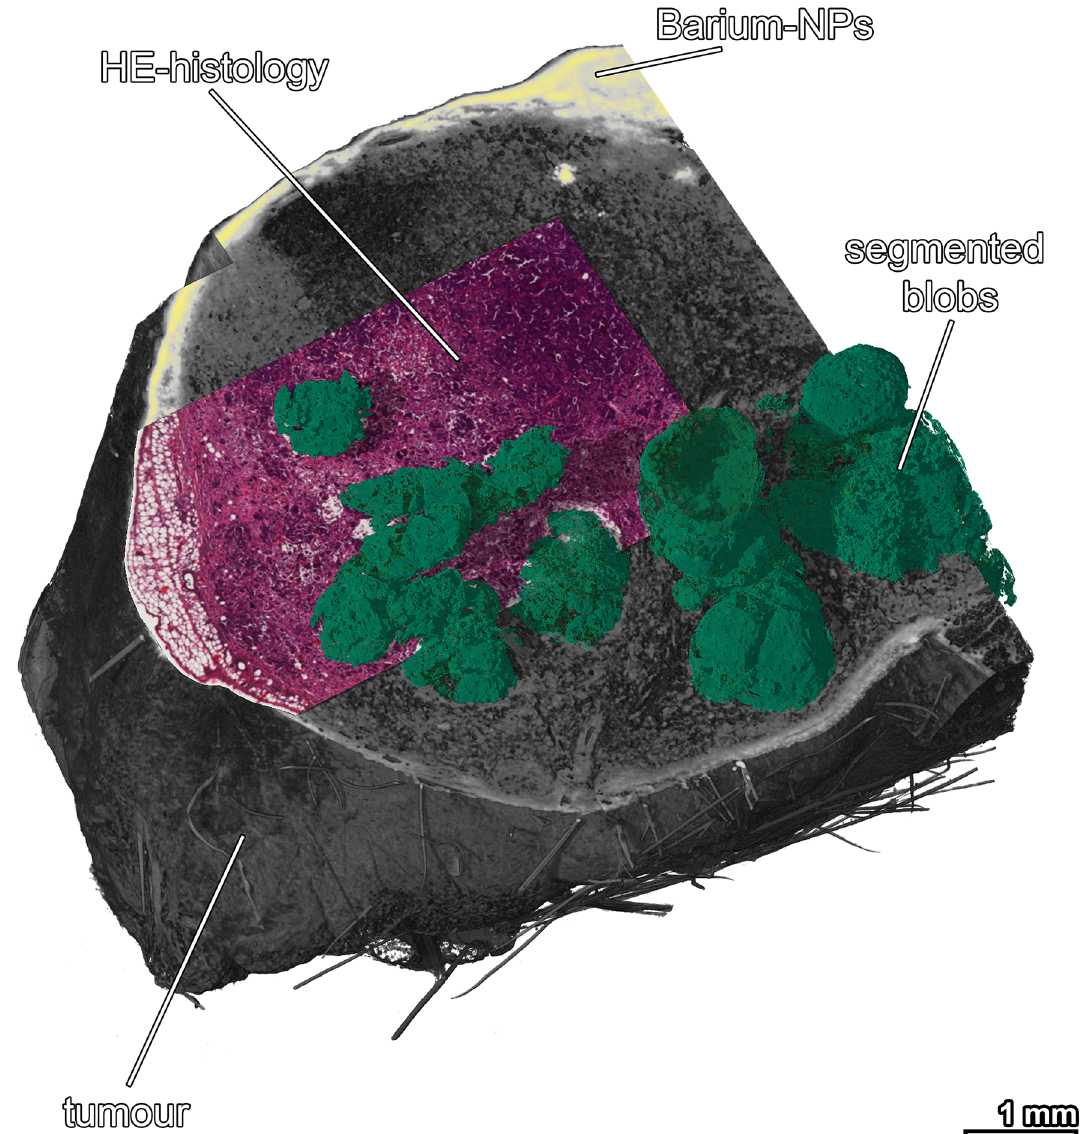
Figure 2. Capabilities of CT-based 3D virtual histology. 3D rendered mouse mamma tumour, virtually cut at the position of the matching HE histological section. Barium NPs are depicted in yellow. Necrotic "blobs" inside the tumour are shown in green. The "blobs" were segmented using a region growing algorithm, embedded in VG